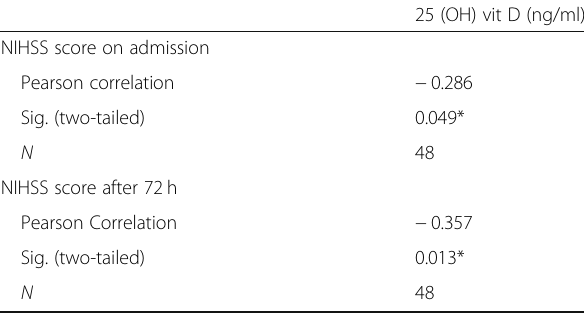
Table 5 Relation between serum vitamin D and stroke severity on presentation and after 72 h by